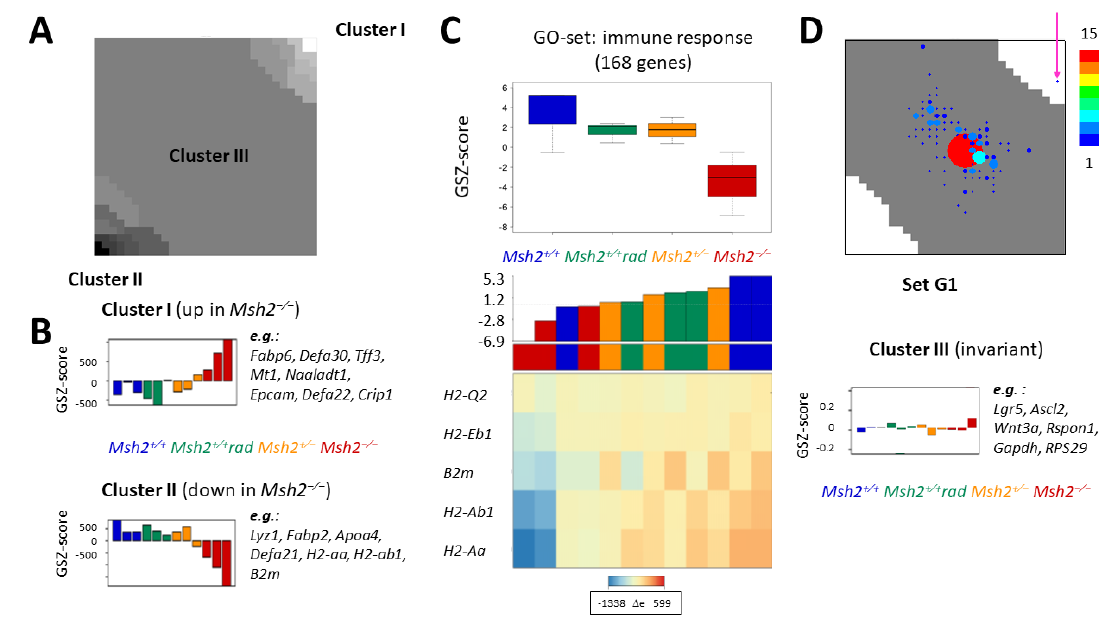
Figure 2. Gene transcription under genomic stress. Results of a self-organizing map (SOM) analysis of RNA-seq data. ( A ) Gene clusters (different grey values) obtained based on correlated gene transcription across all analyzed intestinal samples. ( B ) The gene set enrichment Z- (GSZ) scores of the genes of clusters I (white in A) and II (black in A) are shown for all samples analyzed. Representative genes of the clusters are indicated. ( C ) Transcription of the genes of the gene ontology (GO) set ‘Immune response’ demonstrating their weak down-regulation in Msh2 +/+ rad and Msh2 +/− mice and strong repression in Msh2 −/− mice. Group GSZ-score (upper panel), sample GSZ-score (middle panel), and relative expression ∆ e (RPKM) of the five most pronounced regulated genes of the set (lower panel). The distribution of the entire set within the SOM is given in Figure S2C. ( D ) Characteristics of G1 gene transcription. Except for one (pink arrow), all G1 genes are part of the cluster III of invariant transcription (grey). Color scale: number of genes per metagene. GSZ-scores of all cluster III genes across all samples are shown below.